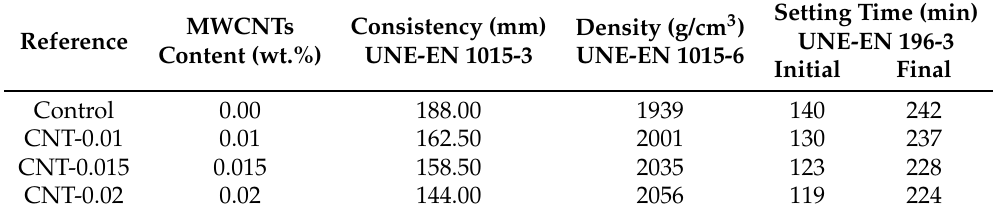
Table 4. Physical properties of the fresh mortars.